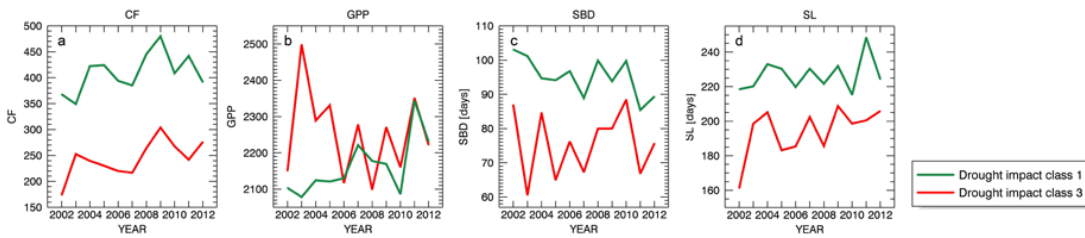
Figure 6. Year-to-year variability observed within the drought impact classes 1 (in green) and 3 (in red) footprints representing respectively, negative and positive correlation to the 3nNDVI PC: ( a ) CF; ( b ) GPP; ( c ) SBD and ( d ) SL (abbreviations as in Figure 3). Significance of class-dependent year-to-year differences was assessed with ANOVA model and is given in Table B4.